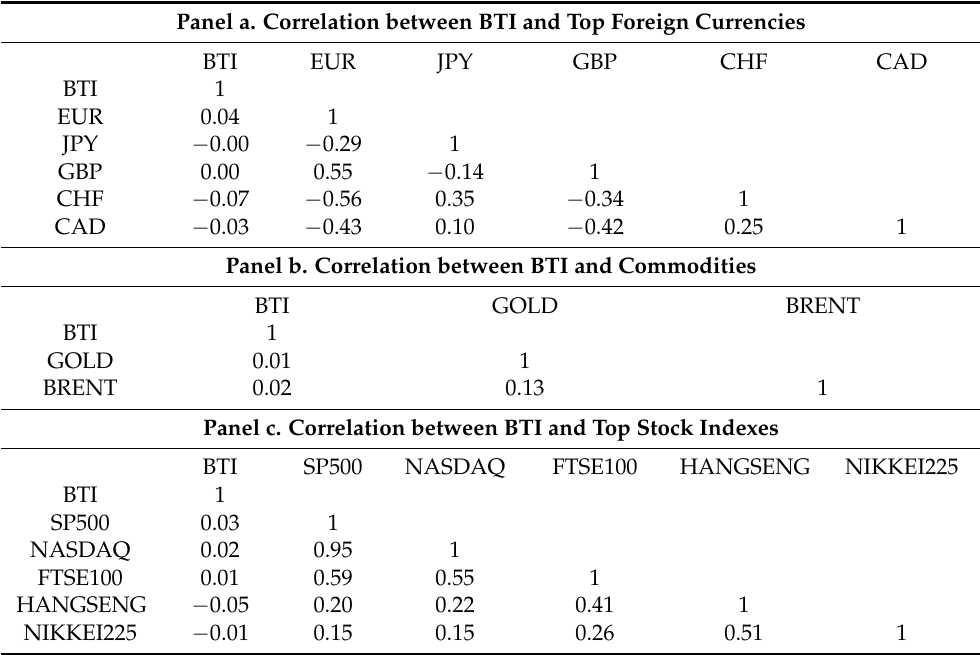
Table 5. Correlation between BTI and other asset classes. Panel a. Correlation between BTI and Top Foreign